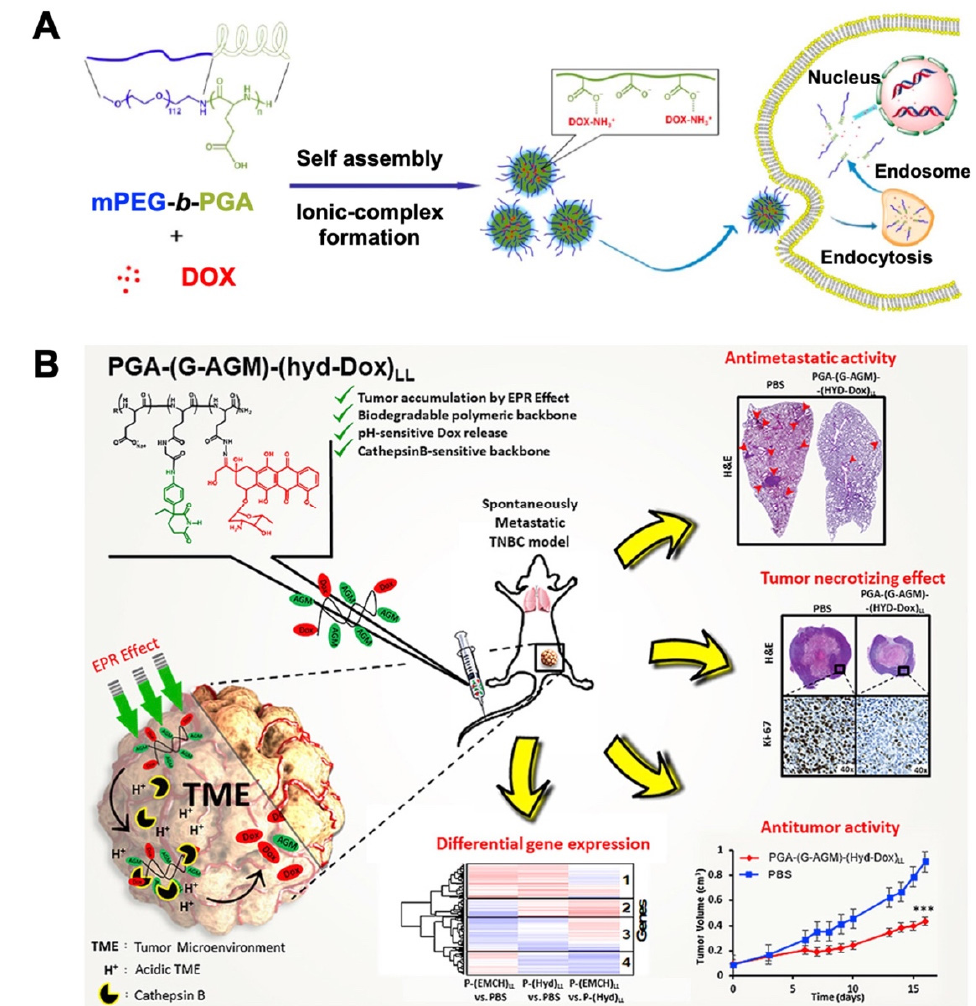
Figure 2. Fabrication of PGA-based nanomaterials by chemical conjugation and physical encapsu- lation of DOX. ( A ) Schematic illustration of the preparation and endocytosis mechanism of the pH–responsive mPEG– b –PGA amphiphiles. Reprinted with permission from Ref. [71]. Copyright 2013, American Chemical Society. ( B ) Synthetic procedures of PGA–based combination conjugates, *** p < 0.001. Reprinted with permission from Ref. [73]. Copyright 2018, Elsevier.